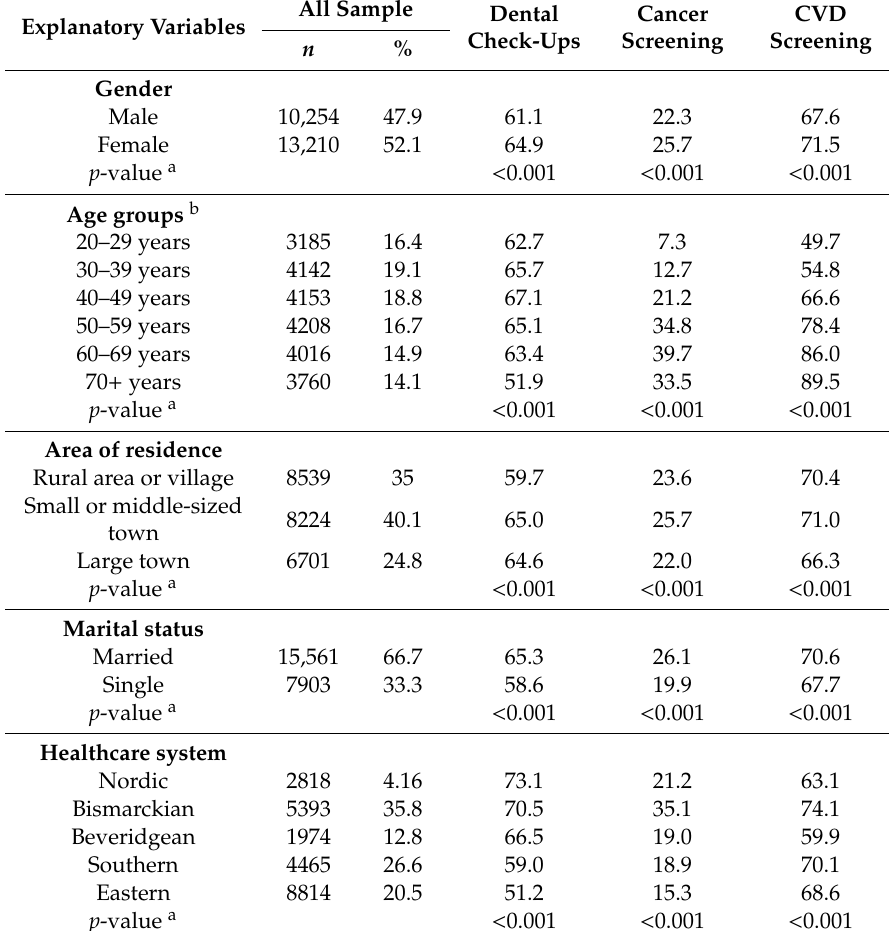
Table 1. Characteristics of the study sample and proportion of people using dental and medical preventive services in the past 12 months, by covariates ( n = 23,464).